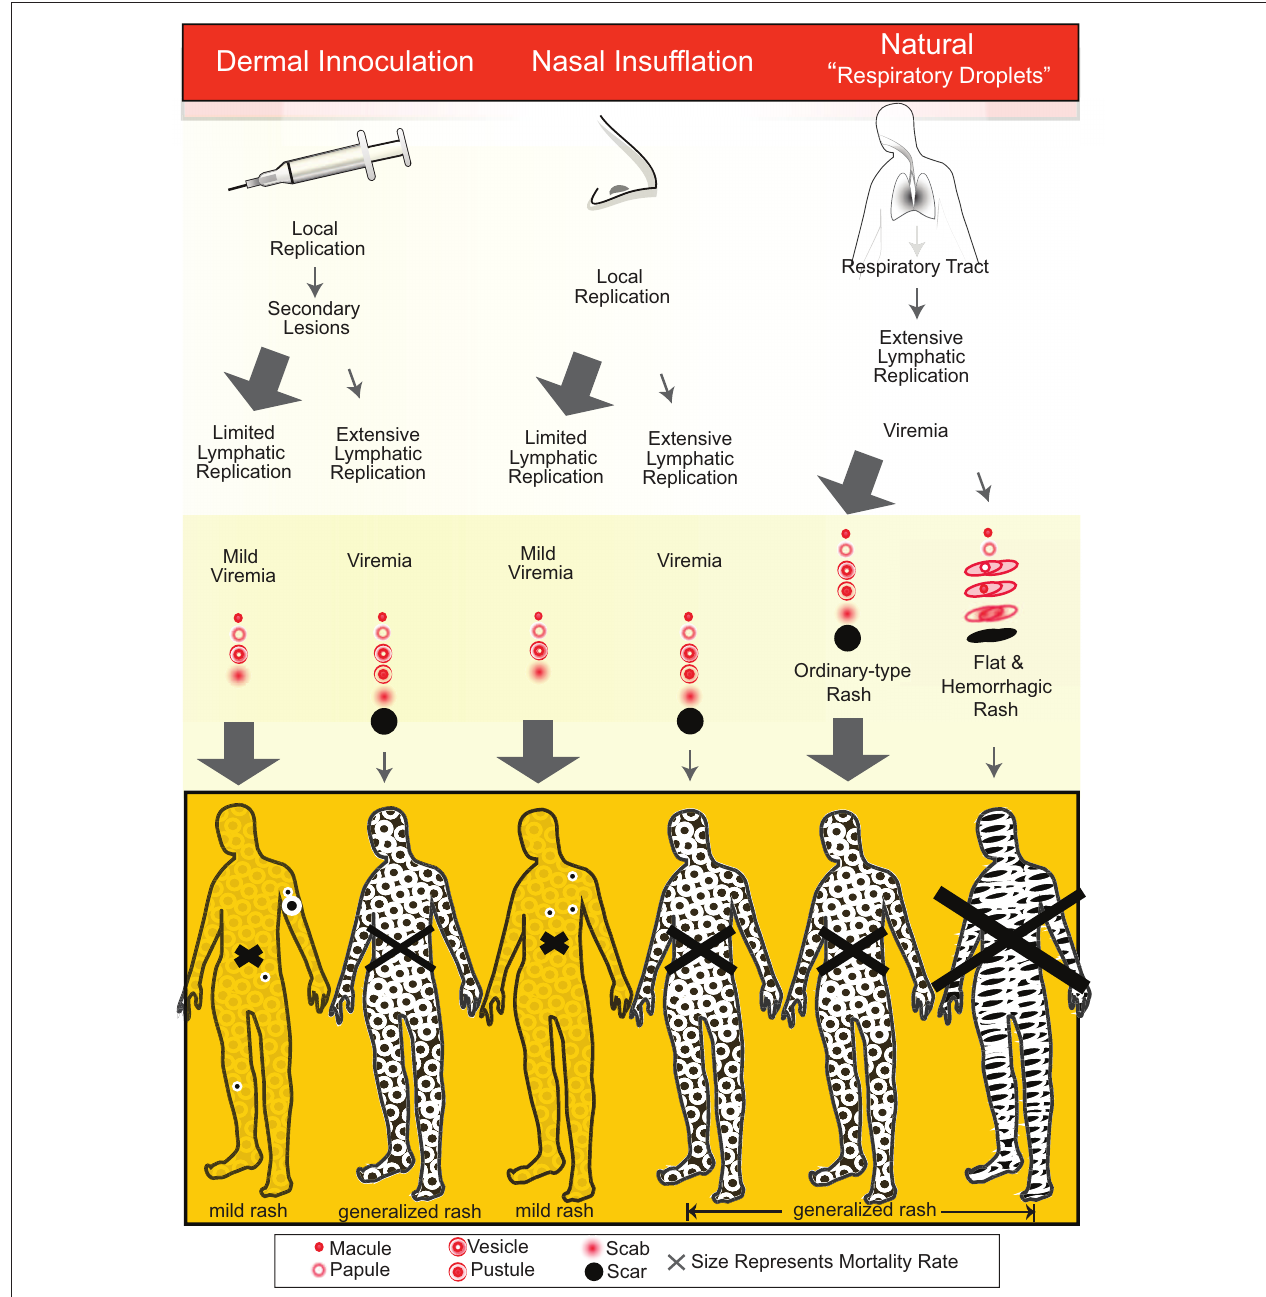
FIGURE 1 | The spread of variola virus around the body [partially adapted from Fenner et al. (1988) Figure 3.1] appears to have frequently been less extensive after dermal inoculation and nasal insufflation compared with naturally acquired infection. This may have been due to less extensive lymphatic replication of virus and limited viremia by dermal